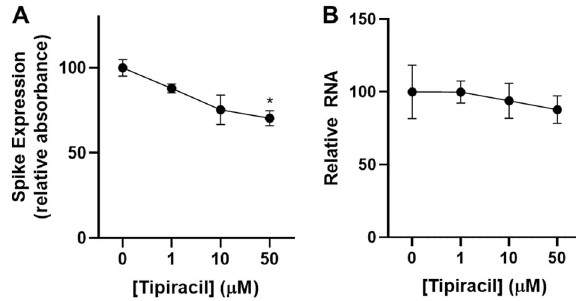
Fig. 3 Inhibition of SARS-CoV-2 coronavirus by Tipiracil in whole-cell assays. A549-hACE2 cells were pre-treated with Tipiracil or carrier (0 mM) for 2 h and infected with CoV-2 at MOI 1. After 48 h, cells were harvested to check ( A ) spike protein and ( B ) RNA expression, * P < 0.05. Raw data for Fig. 3 are included in Supplementary Data fi le.